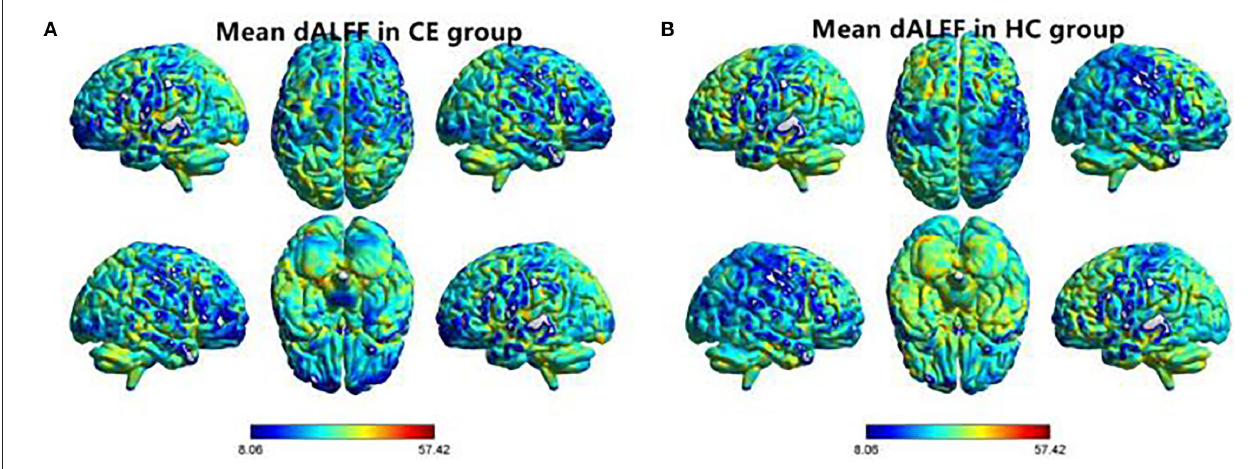
FIGURE 1 | Spatial distribution of dALFF maps within CE group (A) and HC group (B) . CE, comitant exotropia; HC, health control; dALFF, dynamic amplitude of low-frequency fluctuation.